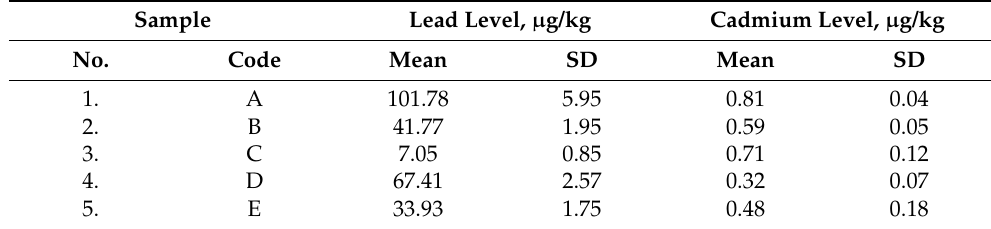
Table 1. The levels of HMIs in the analyzed samples (ointments, µ g/kg); SD—standard deviation.